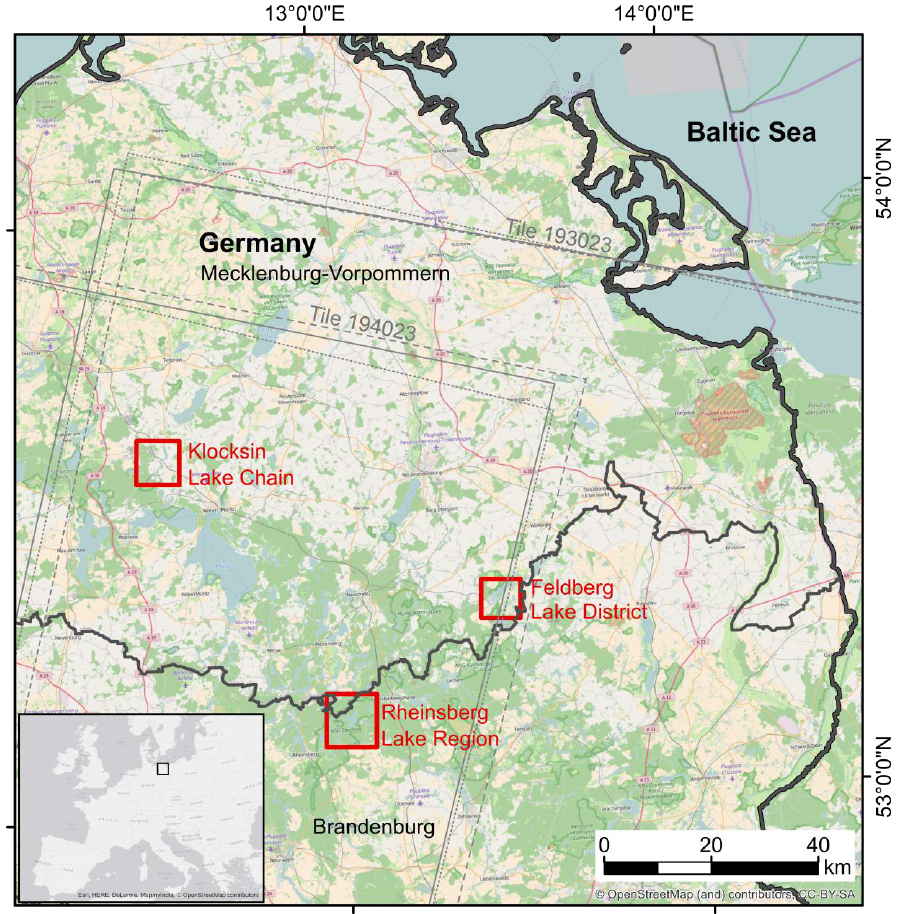
Figure 1. Study area with three selected regions: Feldberg Lake District, the Klocksin Lake Chain, and Rheinsberg Lake Region. The gray lines illustrate the Landsat footprints of the acquisition tiles 193023 and 194023. The gray dashed line shows the footprint of Landsat 5, the solid gray line shows the footprint of Landsat 7, the dotted gray line the footprint of Landsat